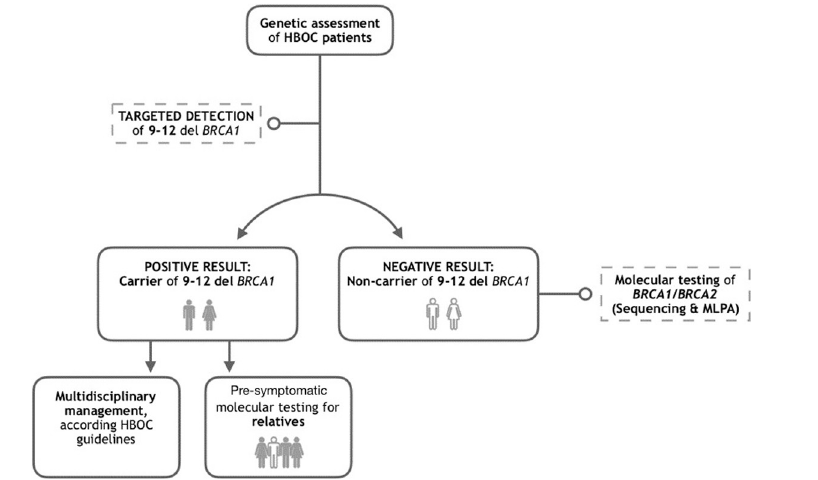
Fig 2. Proposed approach for Mexican hereditary breast and ovarian cancer